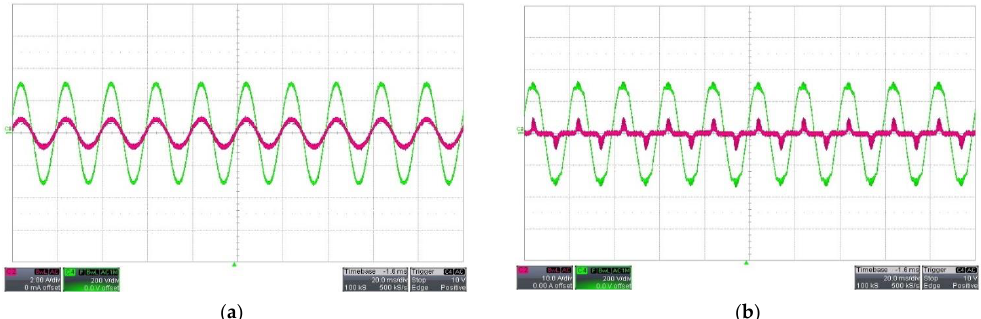
Figure 11. ( a ) Experimental output waveforms of voltage (green) 200 V/div and current (red) 2 A/div under a linear load. ( b ) Experimental output waveforms of voltage (green) 200 V/div and current (red) 10 A/div under a nonlinear load.